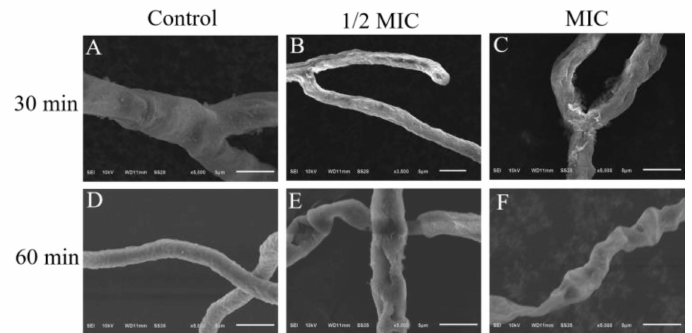
Figure 5. Micrographs of control samples for 30 min ( A ) and 60 min ( D ); Micrographs of P. digitatum hyphae treated with 1/2 MIC γ -CDCL for 30 min ( B ) and 60 min ( E ), or treated with 1 × MIC γ -CDCL for 30 min ( C ) and 60 min ( F ). SEM, scanning electron microscopy; γ -CDCL, cinnamaldehyde/ γ - cyclodextrin inclusion complex; MIC, minimum inhibitory concentration.